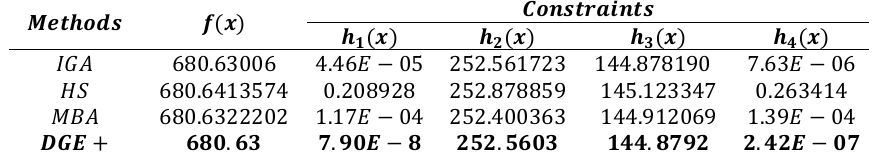
Table 11. Reported results for constrained problem 6 from different optimizers (continued)